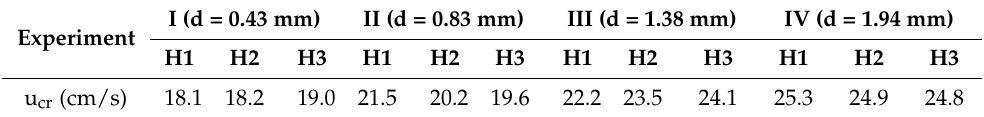
Table 4. Threshold near-bed velocity (cm/s).